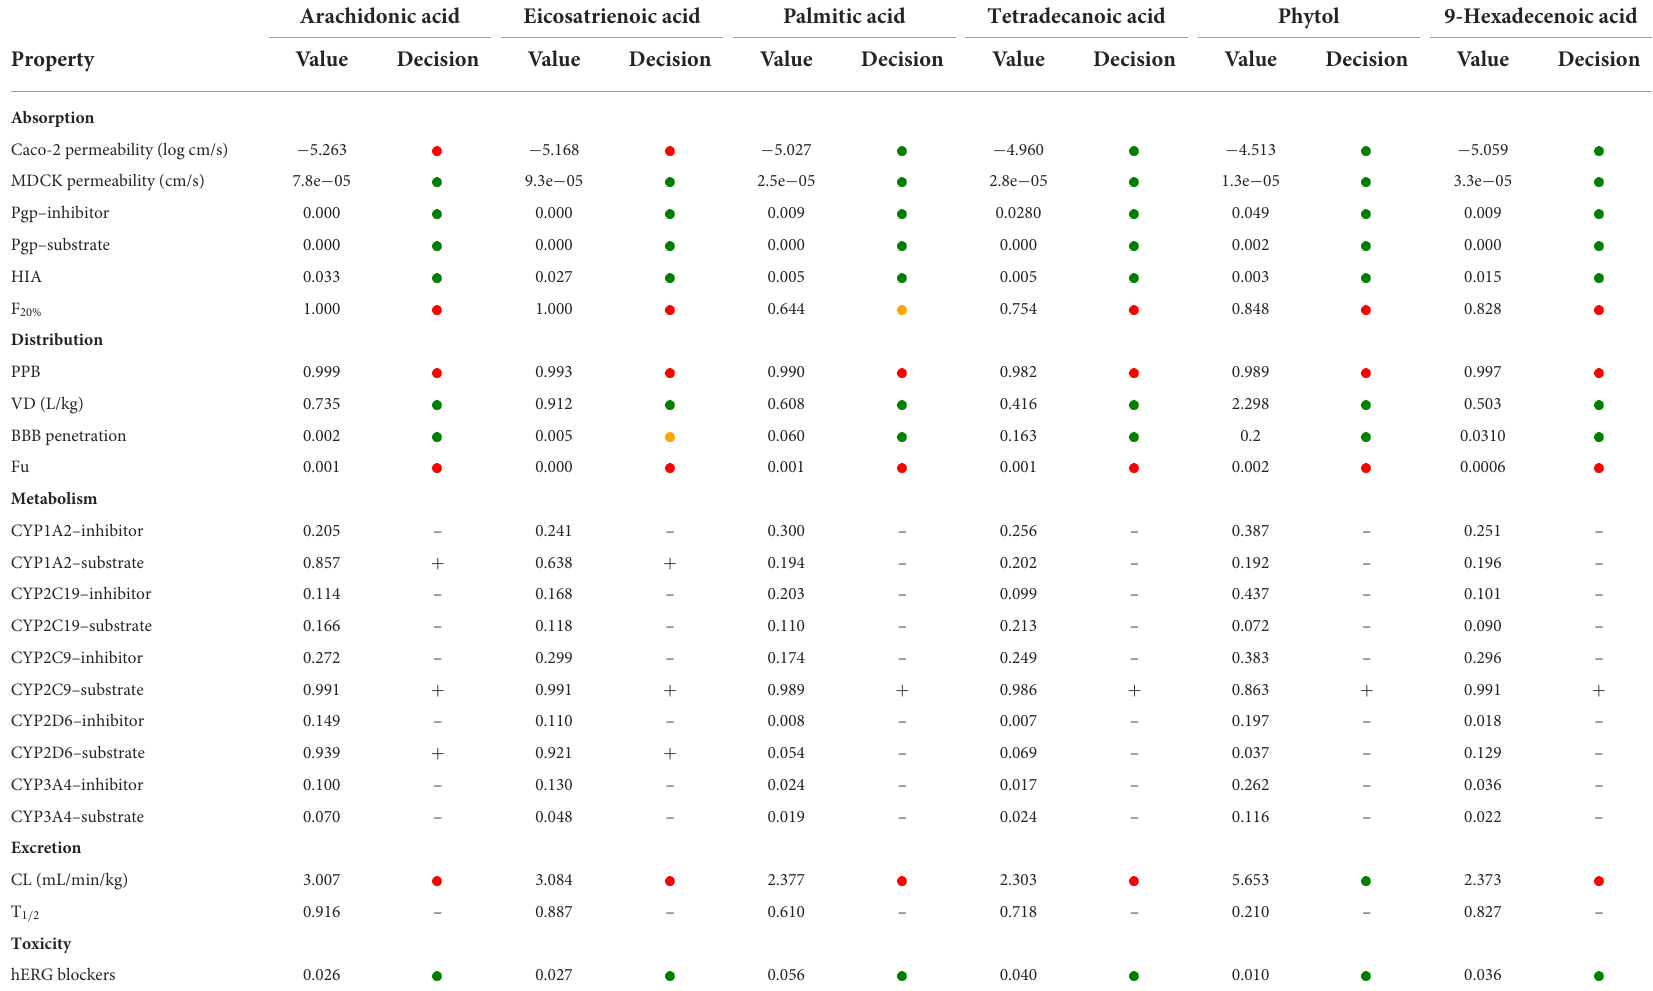
TABLE 2 ADMET and drug-likeness properties of HFFO main ingredient through online prediction tool of ADMETlab 2.0. Arachidonic acid Eicosatrienoic